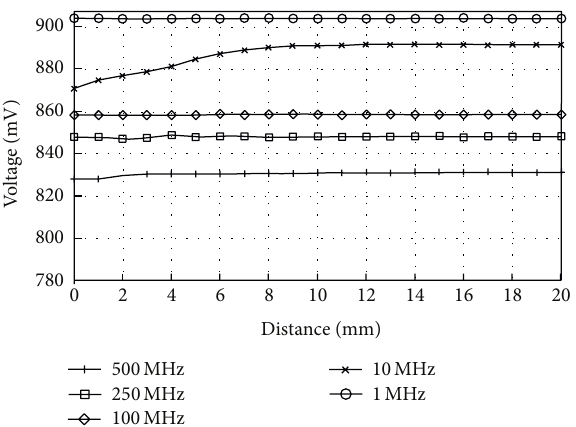
Figure 14: Voltage variations on reader coil versus distance. Trans- mission medium between coils: 1mm of pork skin, 1mm of fat, and 2 mm of